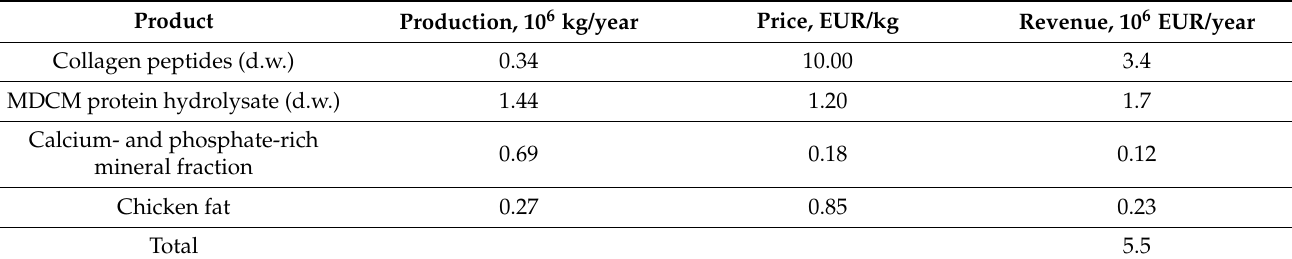
Table 4. Annual production and sales revenues of different chicken MDCM side